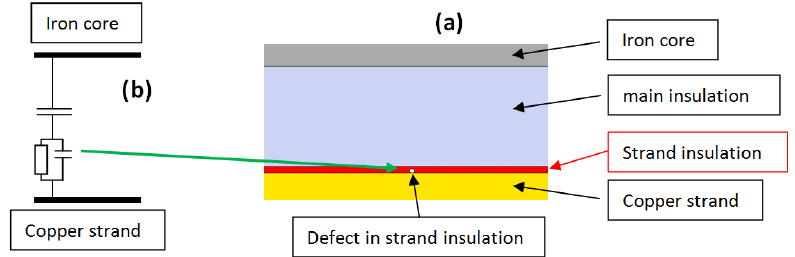
Figure 11. In figure ( a ), the defect is related to the strand insulation but is localized in front of the main insulation wall. The defect can be a void or a local de-lamination. It acts as a resistance in parallel with a capacitor ( b ) and can ignite partial discharges.